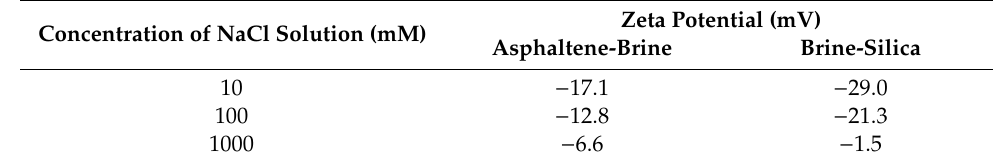
Table 1. Zeta potentials at different interfaces.